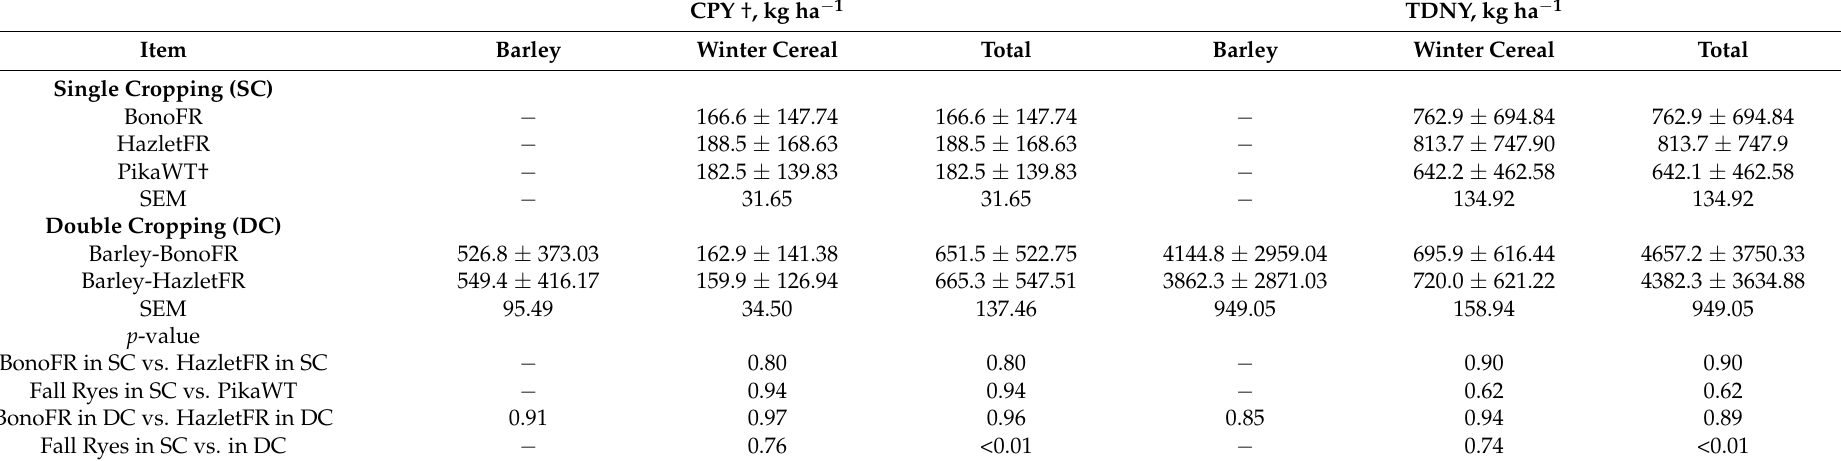
Table 7. Estimated crude protein and total digestible nutrient yield (means ± SD) from whole-crop winter cereals in single and double cropping